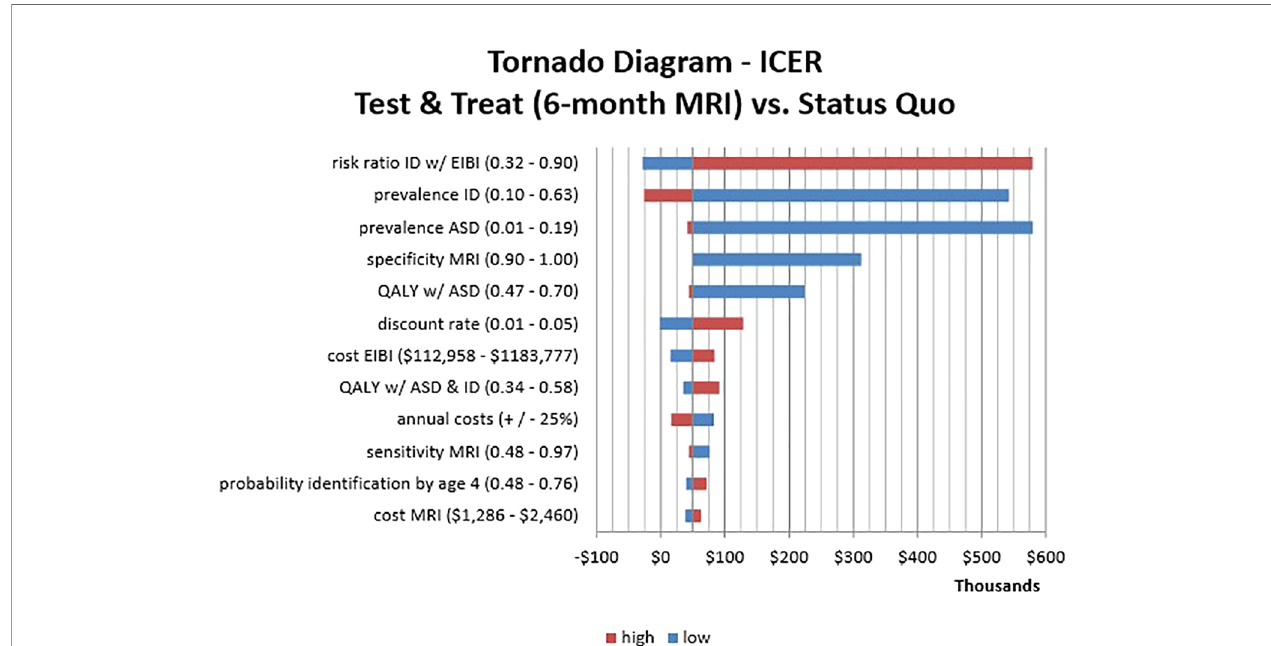
FIGURE 2 | One-Way Sensitivity Analysis Tornado Diagram. This visualization identi fi es which parameters affect the incremental cost-effectiveness ratio (ICER) of Test & Treat strategy (6-month MRI) compared to the Status Quo. The horizontal axis shows ICER values while the vertical axis shows parameter estimates with corresponding high/low input values. The bar length is the change in ICER that results from varying the parameters across the speci fi ed range. Bar colors indicate the direction of the input value (high/low) and the resulting